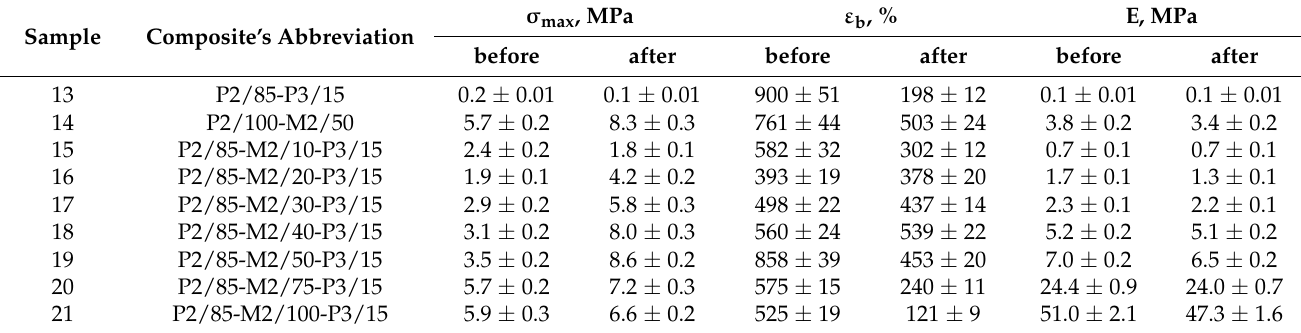
Table 3. Mechanical properties of P2 -based composites before and after HT.